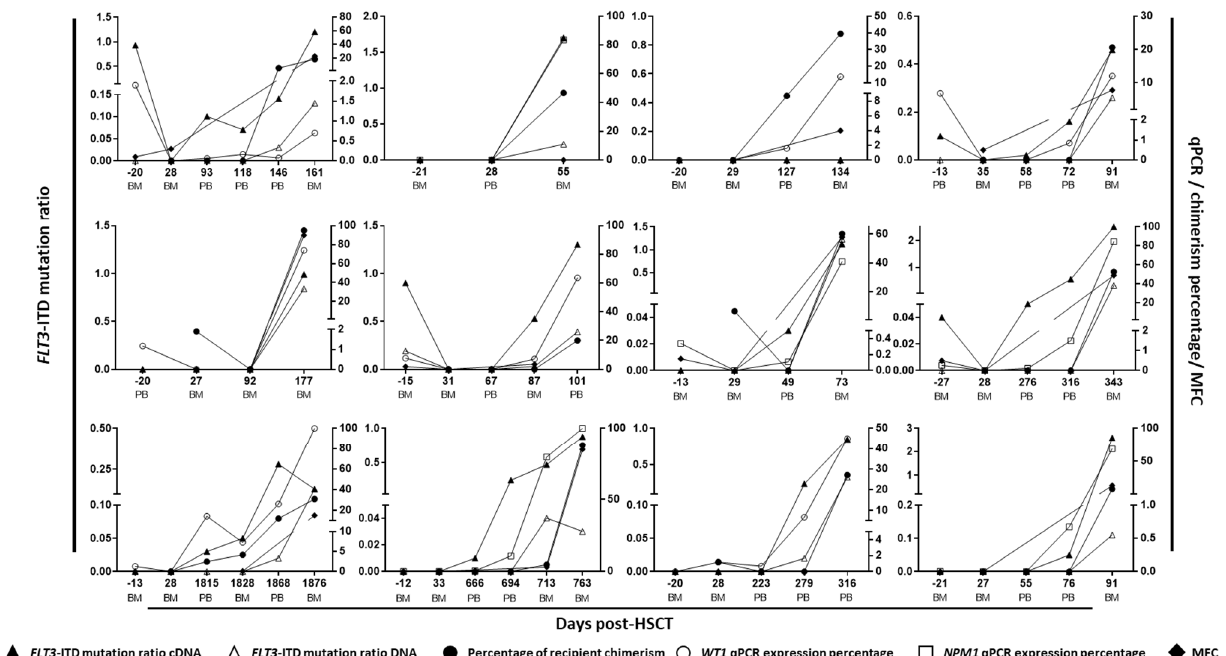
Figure 4. Follow-up monitoring of the 12 patients who relapsed from post-allo-HSCT cohort, includ- ing DNA and cDNA FLT3 -ITD mutation, chimerism and NPM1 and WT1 expression analysis. MFC: multiparametric flow cytometry. HSCT: hematopoietic stem cell transplantation. BM: bone marrow sample. PB: peripheral blood